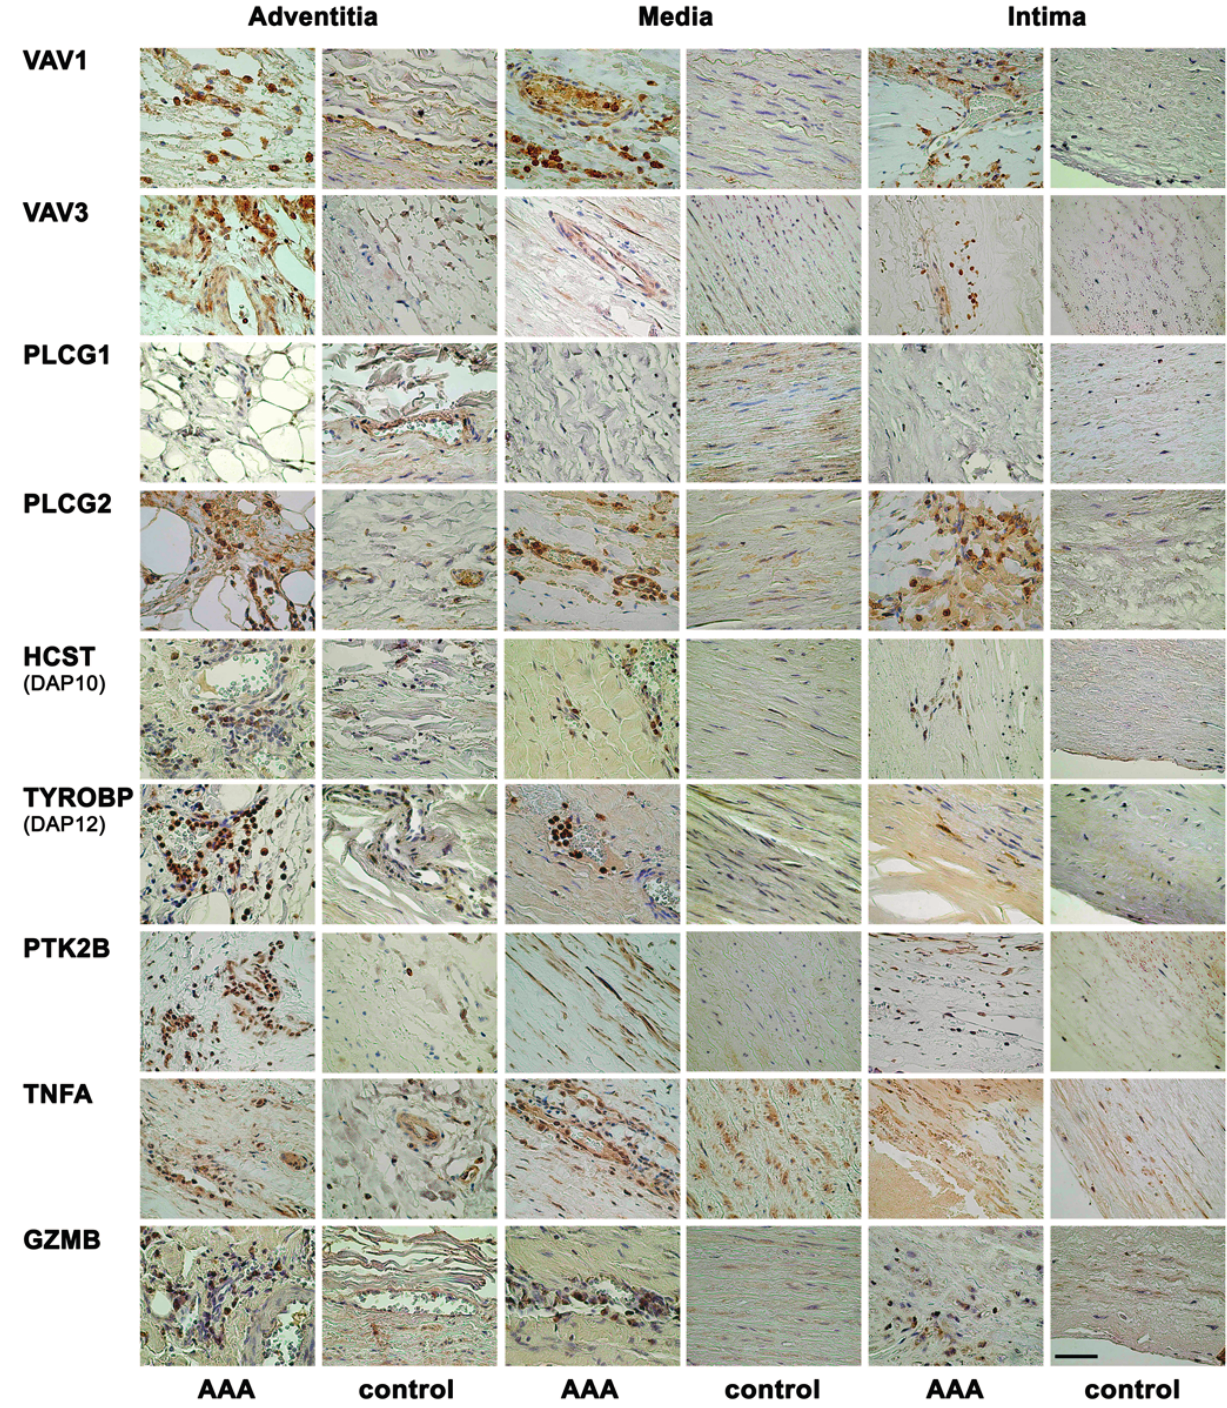
Figure 2. Immunohistochemical staining with antibodies against nine different proteins representing the NK pathway. Each row shows representative immunohistological images for the indicated antibodies on AAA tissue and control abdominal aortic tissue. Most antibodies demonstrated staining on inflammatory cells in the AAA tissue. See Tables 1 and 2 for details on the aortic tissues and antibodies used, respectively. Scale bar = 50 μ